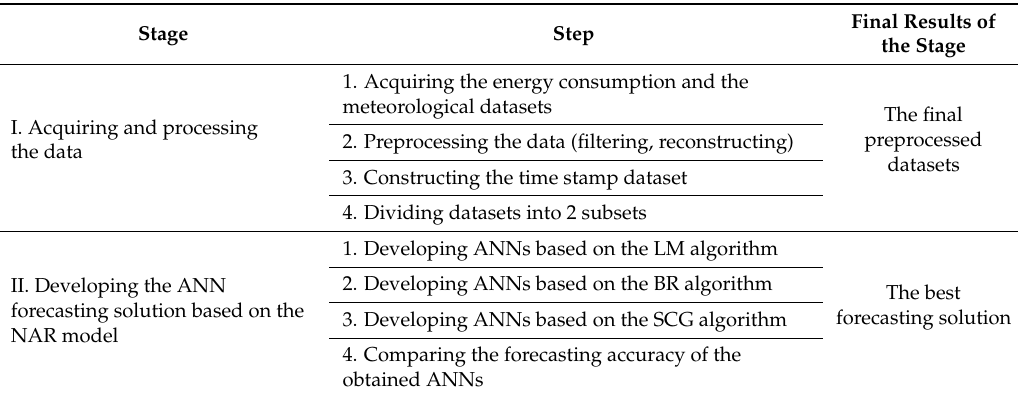
Table 1. A synthesis of the methodology’s stages and